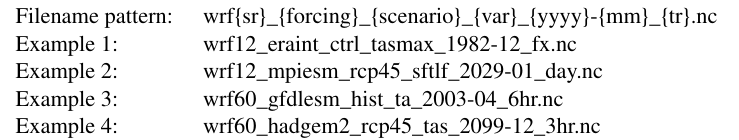
Table A4. File naming convention for the WASCAL WRF ensemble. Here, { sr } denotes the spatial resolution in km, { forcing } the forcing model, { scenario } the scenario, { var } the variable, { yyyy } – { mm } the year and month, and { tr } the output interval (temporal resolution). Filename